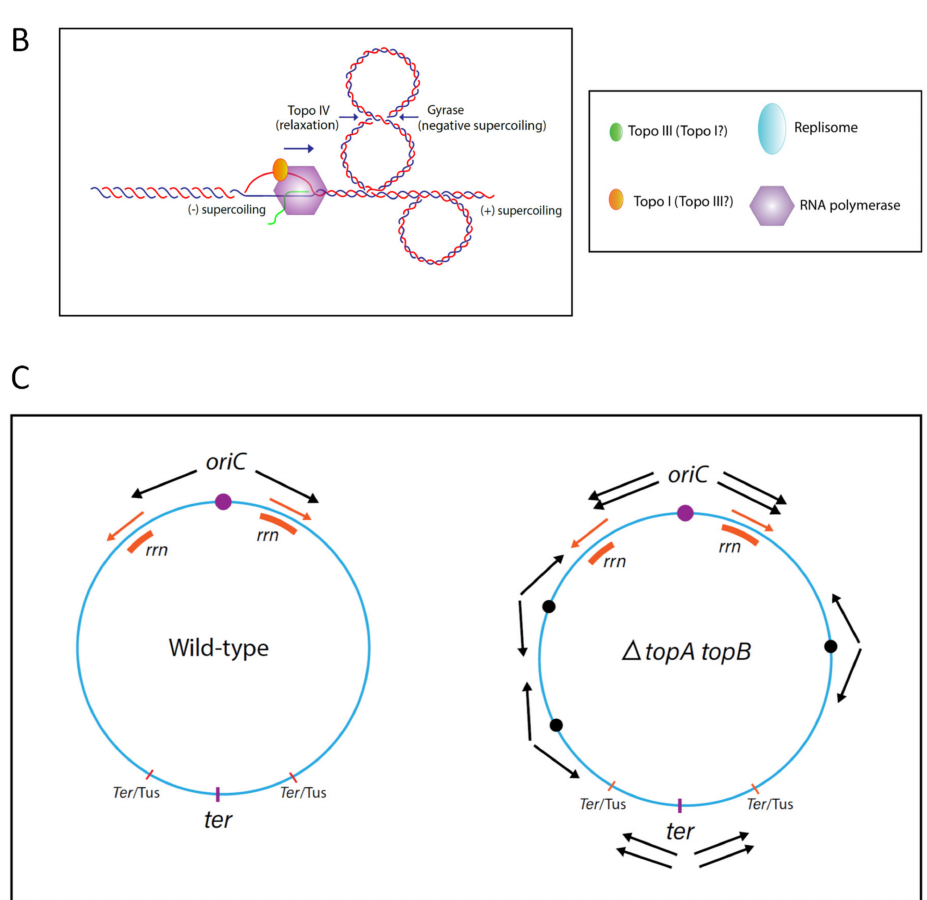
Figure 1. Model for the e ff ects of deleting topA and topB on replication in E. coli cells. ( A ) Topological problems associated with replication elongation (1), replication termination (2 and 3) and head-on conflicts between replication and transcription (4). ( B ) Supercoiling during transcription. ( C ) In wild-type cells, bi-directional replication is initiated at oriC and is terminated when replication forks converge in the Ter region. Replication forks are trapped in the Ter region via the Ter / Tus barriers [106]. In Escherichia coli cells lacking type 1A topos, the topological problems illustrated in A are exacerbated because of over-replication from oriC and PriA-dependent replication initiation (e.g., R-loops) that takes place outside of oriC . Black and red arrows indicate the direction of, respectively, replication and transcription ( rrn operons). The absence of type 1A topos activity during replication further aggravates the topological problems. See text for